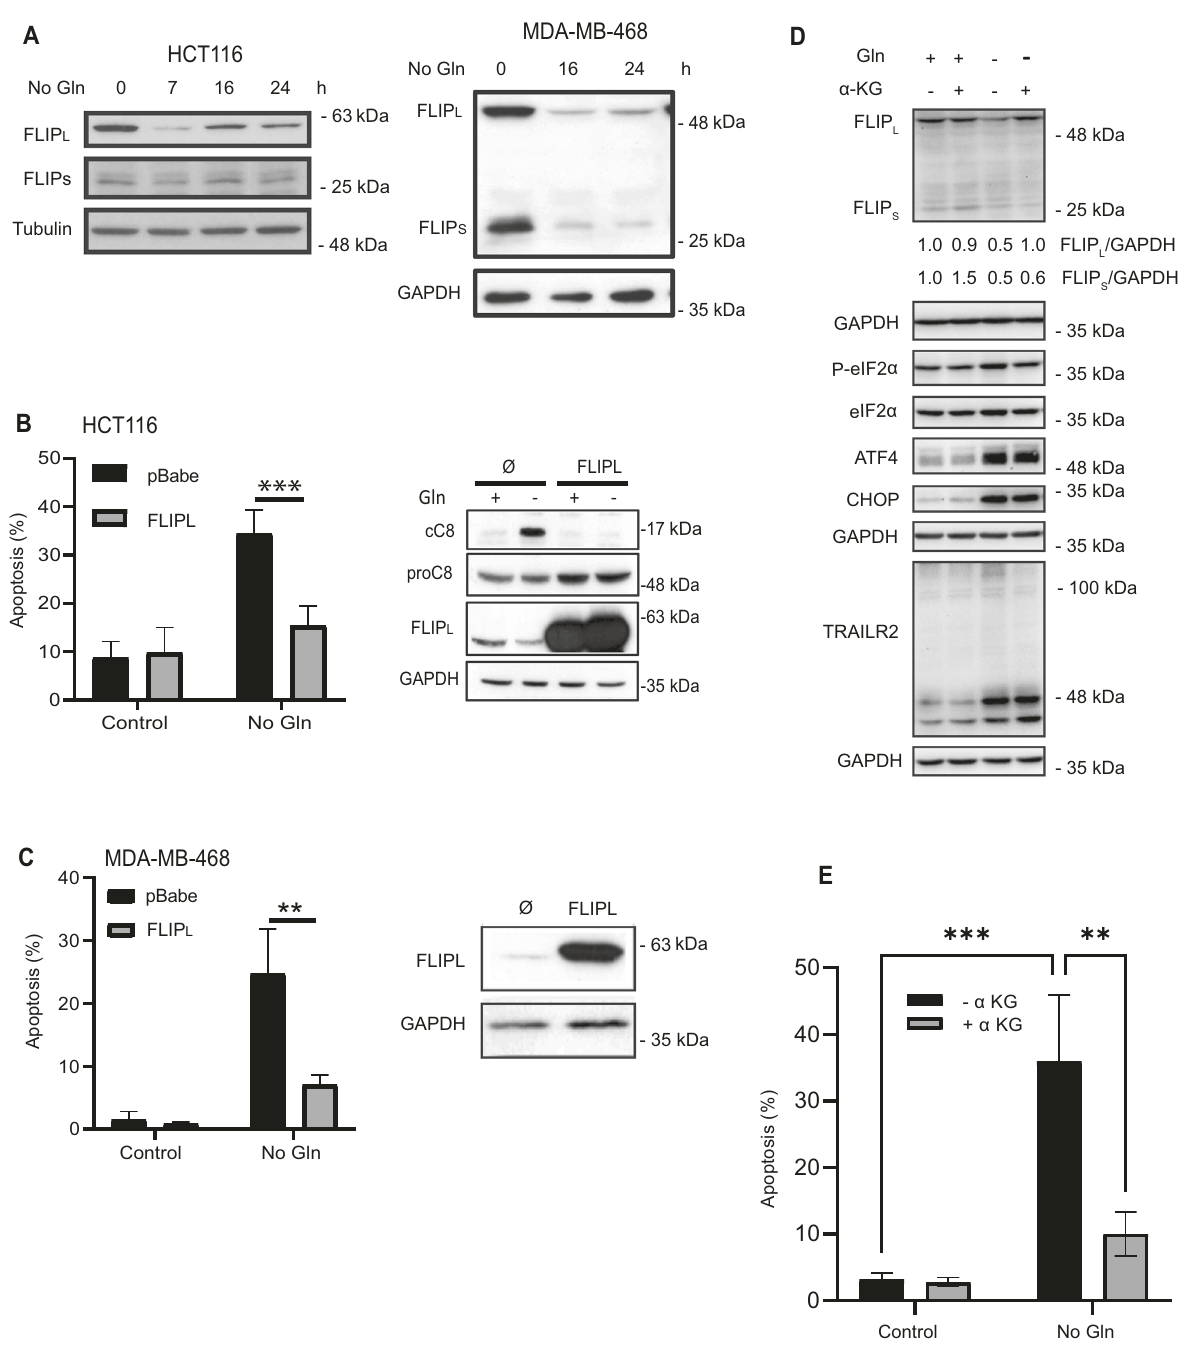
Fig. 6 Role of FLIP in cell death induced by glutamine deprivation. A HCT116 (left panel) or MDA-MB468 (right panel) cells were cultured in the presence or absence of glutamine for the indicated times. Tubulin and GAPDH were used as protein-loading controls. Following these treatments, FLIP L and FLIP S levels were assessed by Western blotting. B Apoptosis was assessed in pBabe or FLIP L overexpressing HCT116 cells cultured in the presence or absence of glutamine for 48 h (left panel). Procaspase-8 levels, caspase-8 activation (cC8) and FLIP L overexpression were determined by Western-blotting after 30 h of glutamine starvation (right panel). C Apoptosis was assessed in pBabe or FLIPL- overexpressing MDA-MB468 cells cultured in the presence or absence of glutamine for 48 h. FLIP L overexpression was detected by Western blotting. In B and C data are presented as mean ± SD from at least three independent experiments. ** P < 0.01; *** P < 0.001; two-way ANOVA test. Tukey ’ s multiple comparison test. D HCT116 cells were cultured in the presence or absence of glutamine for 16 h, with or without dimethyl α -ketoglutarate (5 mM). FLIP levels, ISR activation and TRAIL-R2 upregulation were assessed by Western blotting. In E apoptosis was assessed in HCT116 cells cultured in the presence or absence of glutamine for 48 hours, with or without dimethyl α -ketoglutarate. Data are presented as mean ± SD from at least three independent experiments. ** P < 0.01; *** P < 0.001; two-way ANOVA test. Tukey ’ s multiple comparison